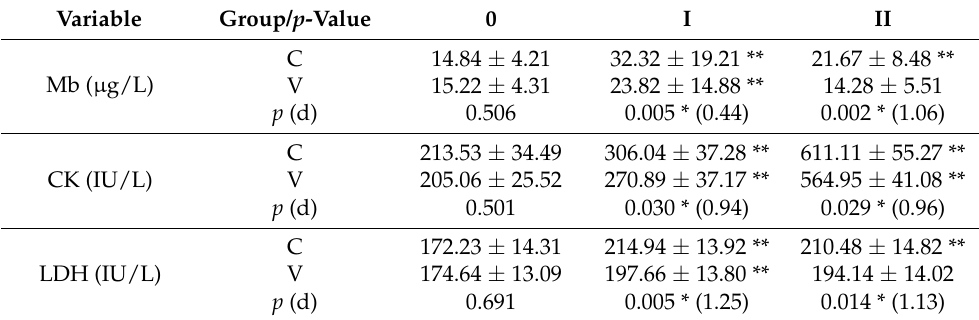
Table 3. The concentration of myoglobin (Mb), activity of creatine kinase (CK), and lactate dehydro- genase (LDH) before (0), immediately after the renewal procedure (I), and 24 h (II) after the end of the exercise test in the group subjected to post-exercise therapy (V) and in the control group (C). Variable Group/ p -Value 0